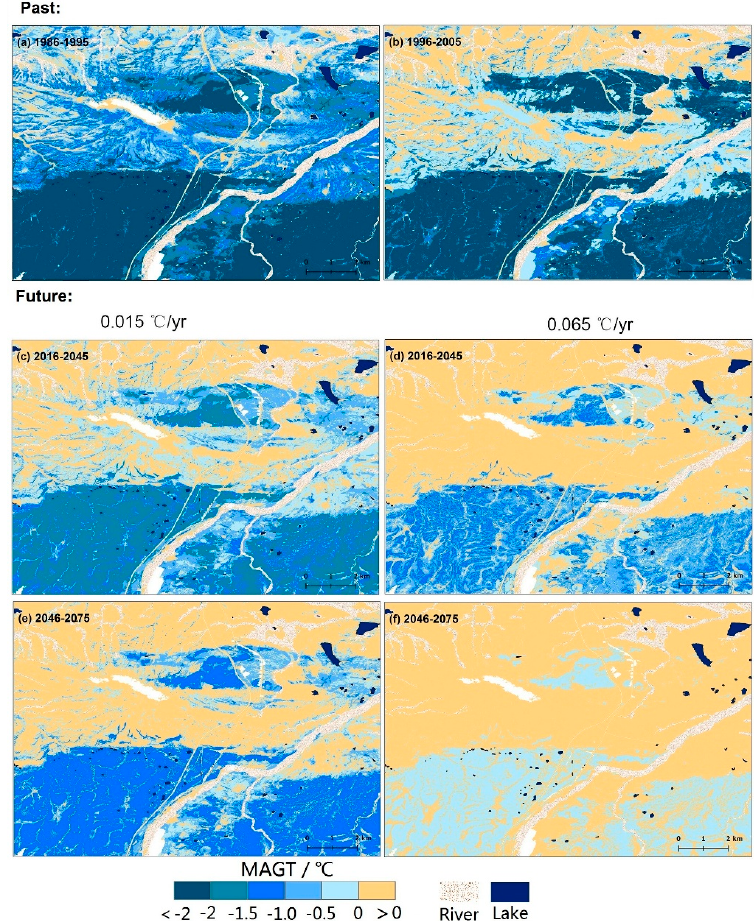
Figure 7. Modeled evolution of the ground temperatures at 10 m for different periods. ( a ) 1986–1995, ( b ) 1996–2005, ( c , d ) 2016–2045 for the low- and high-rate runs, ( e , f ) 2046–2075 for the low (0.015 °C yr − 1 ) and high (0.065 °C yr − 1 ) climate warming trends.